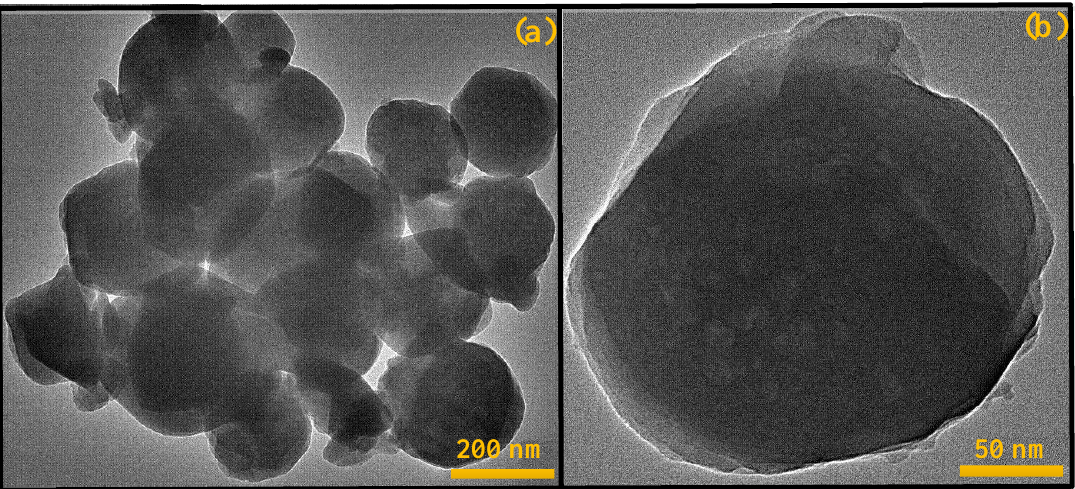
Figure 6. TEM images of the Co-ZIF catalyst. ( a ) fresh catalyst at magnification of 100,000; ( b ) fresh catalyst at magnification of 400,000.